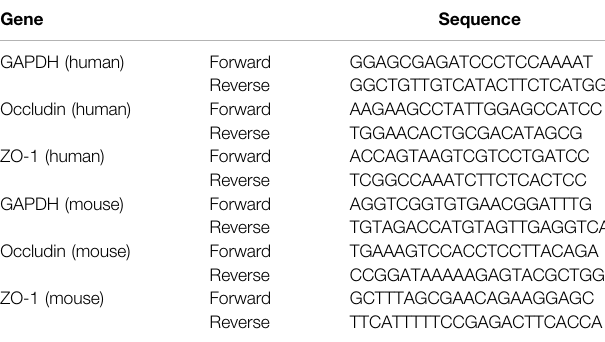
TABLE 1 | Primer sequences used in the RT-PCR analysis.